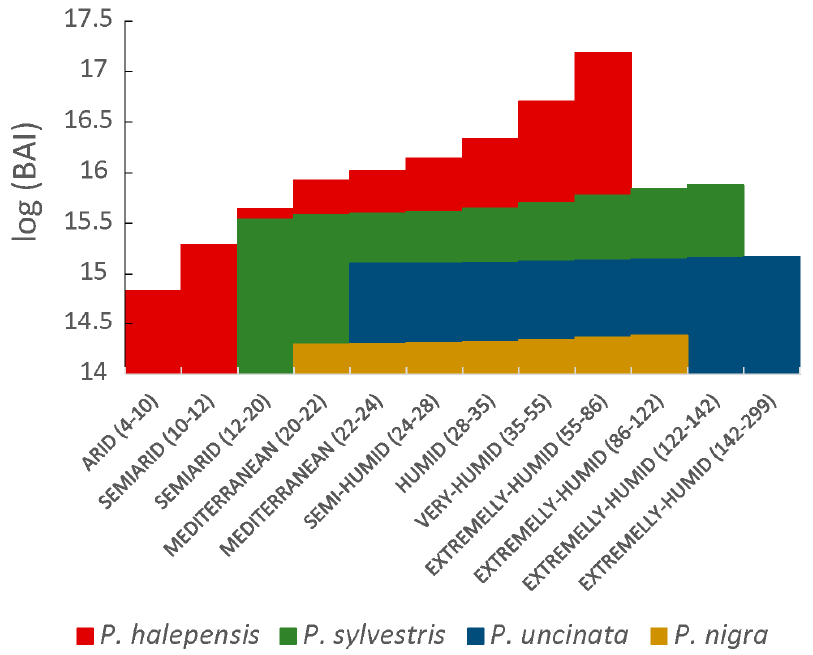
Figure 6. Estimated log BAI gain (in 1/100 mm 2 ) of a hypothetical 100 years old tree over all climate conditions where the species are present for all species.